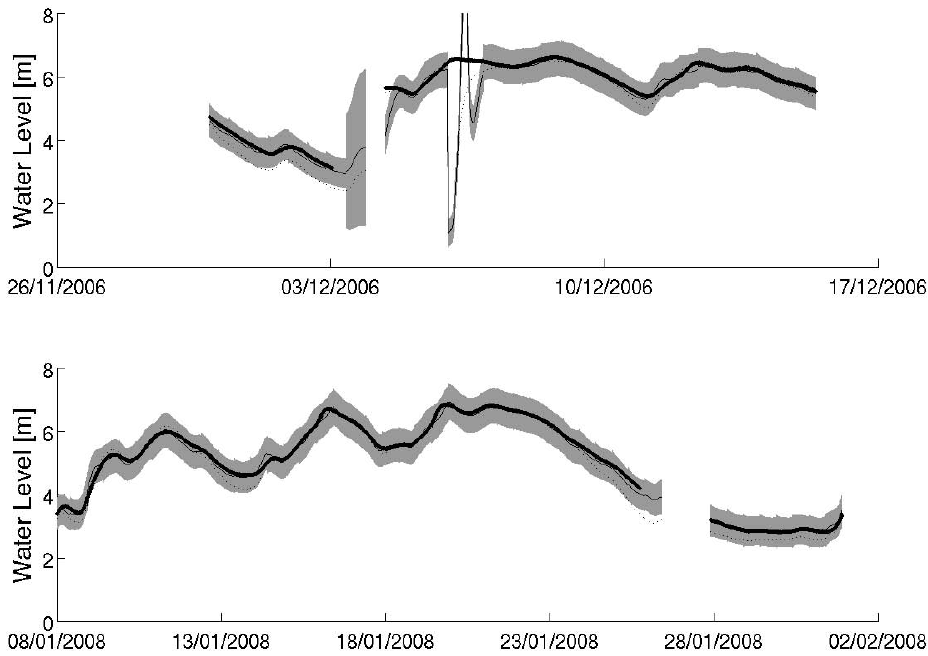
Fig. 7. Examples of 6h ahead forecasts given at Llanrinio for two large flood events during calibration (upper pane) and validation (lower pane) periods generated using the SLLT model calibrated using the SEFE methodology with empirical error bounds. The shaded area represents the 95% prediction confidence interval with the solid line being the expected value of the predictions. Observed data points are also shown along with the deterministic model forecast (dotted